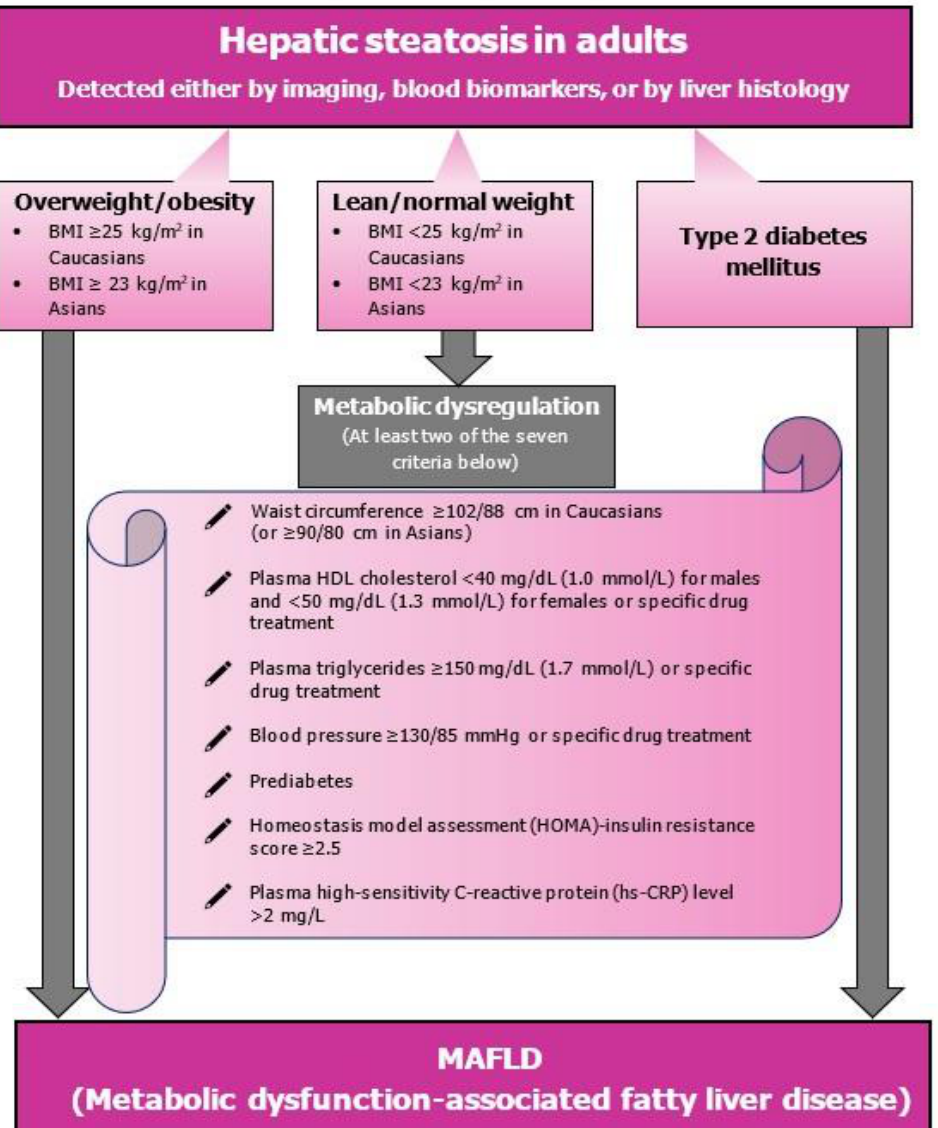
Figure 1. In a bid to raise awareness of the disease, a multidisciplinary group of experts recom- mended changing the definition and nomenclature of NAFLD to metabolic dysfunction-associated fatty liver disease (MAFLD). MAFLD is diagnosed in patients with steatosis and at least one of the three criteria: obesity/overweight, type 2 diabetes mellitus and any evidence of metabolic dysregu- lation. NAFLD — non-alcoholic fatty liver disease; MAFLD — metabolic dysfunction-associated fatty liver disease.